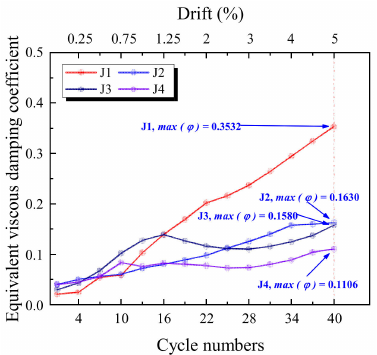
Figure 20. Equivalent viscous damping